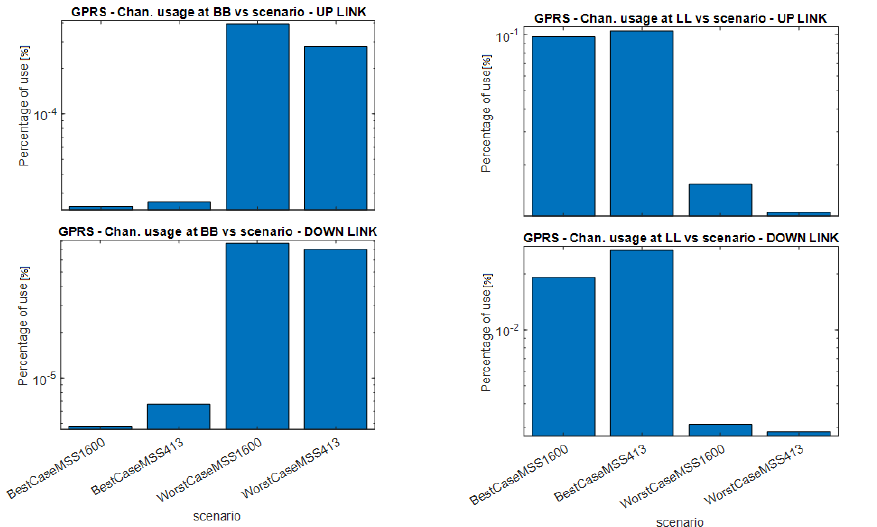
Figure 7. Usage for the Local-Loop (LL) and Back-Bone (BB) on the up and down link for Scenario A.